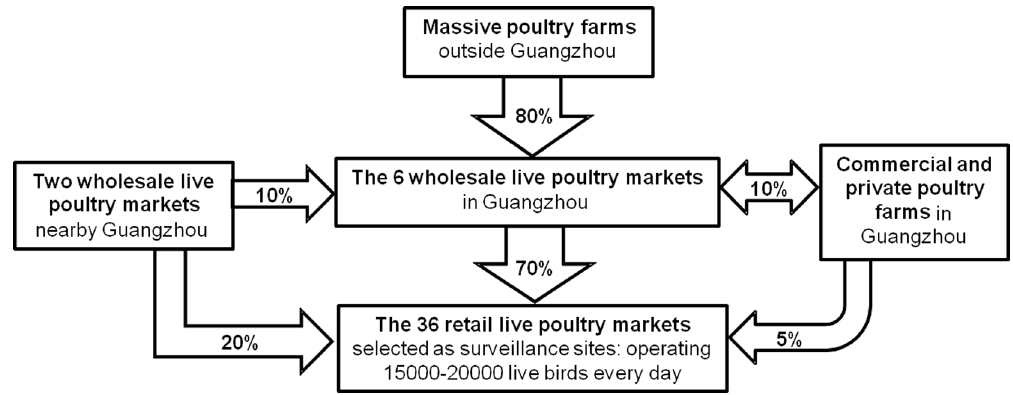
Figure 2. The general routes of live poultry transmission in Guangzhou, China.